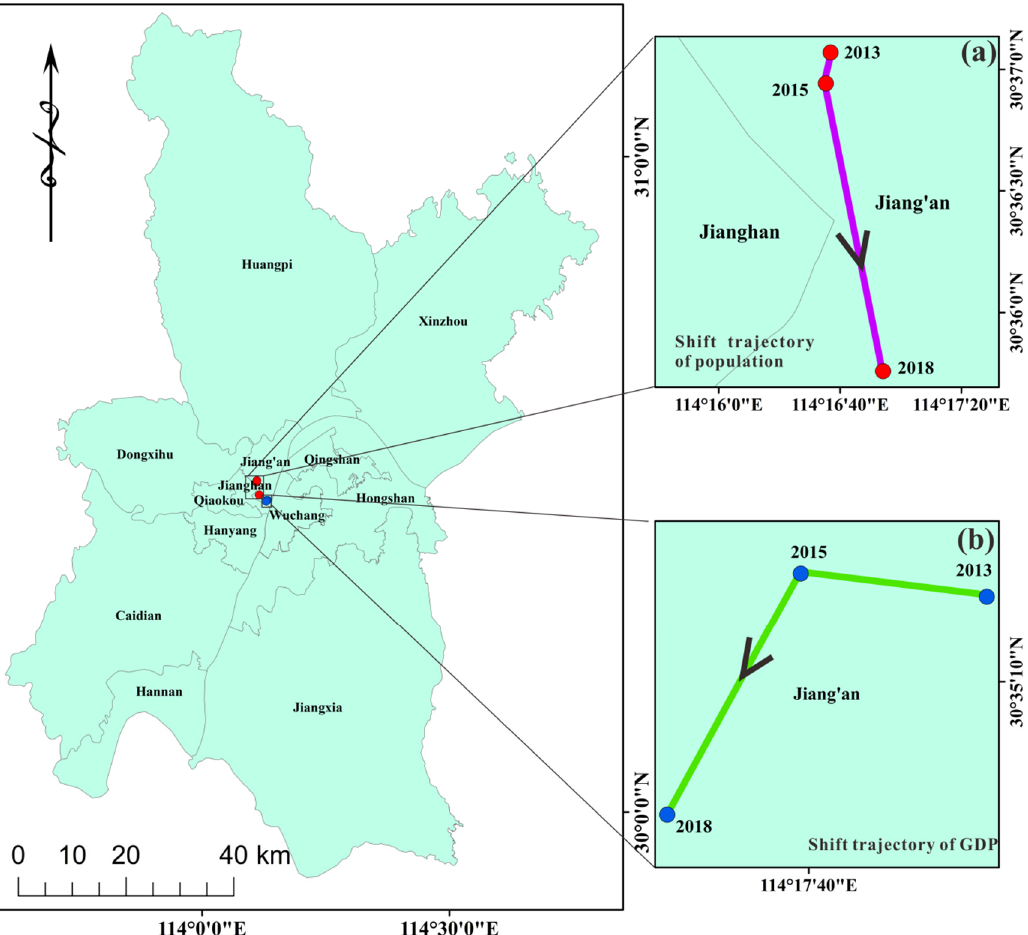
Figure 13. The shift trajectory of population and GDP gravity center of Wuhan during 2013–2018: ( a ) the shift trajectory of the population gravity center; ( b ) the shift trajectory of GDP gravity center.